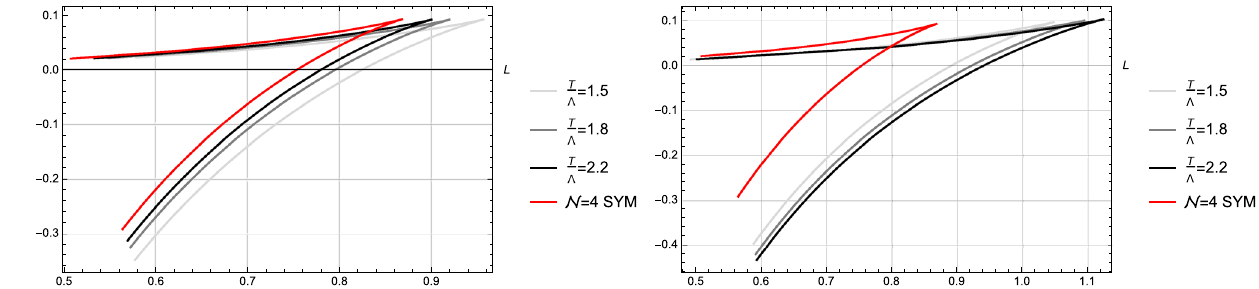
Fig. 1 The heavy quark potential versus the interquark distance for different values T /(cid:2) : Left: large blackhole, Right: small blackhole